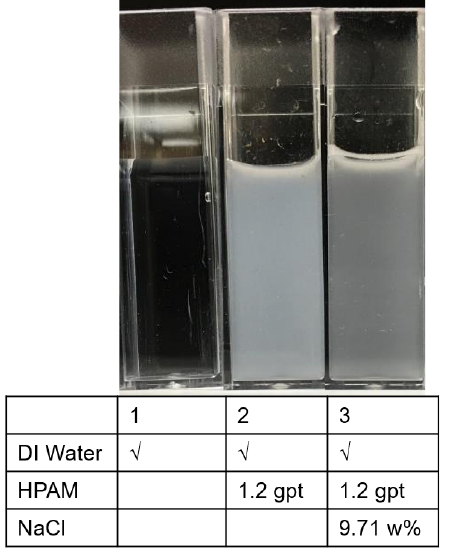
Figure 18—HPAM vs. a less-damaging FR in NaCl